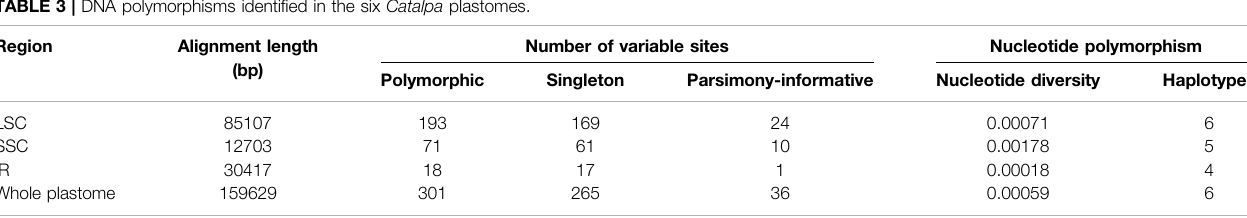
TABLE 3 | DNA polymorphisms identi fi ed in the six Catalpa plastomes.